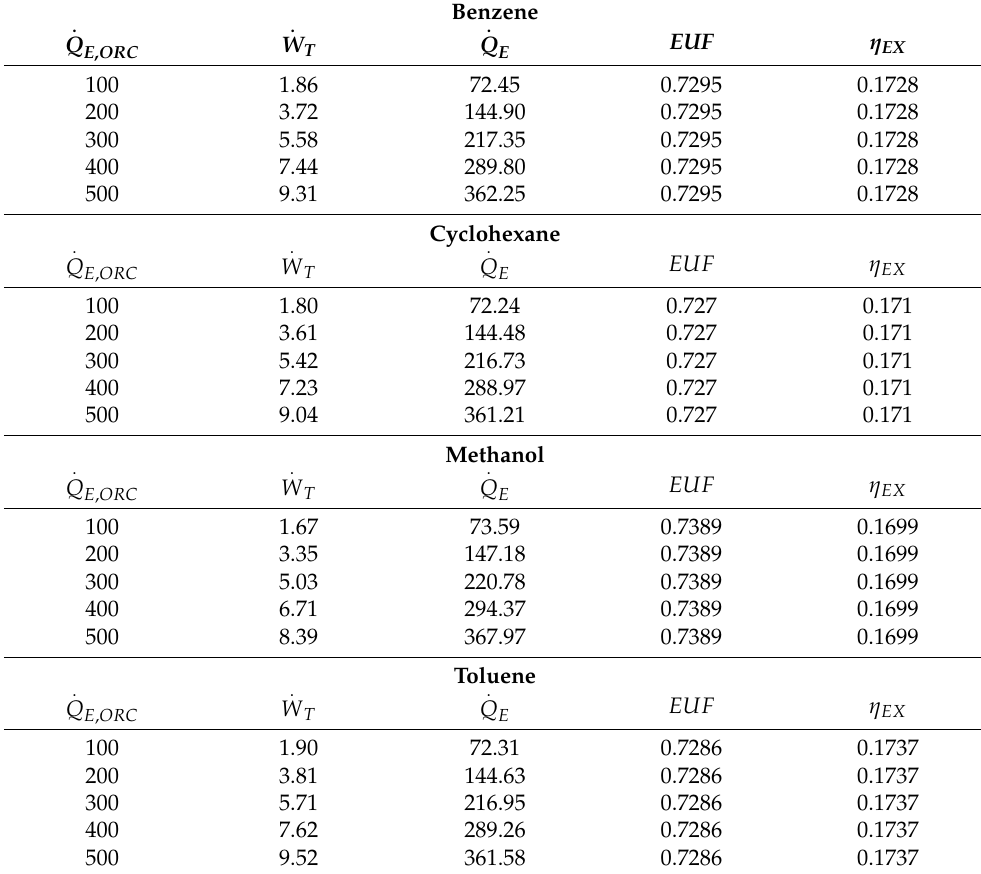
Table 12. Influence of the heat supplied for the different working fluids at one selected operating